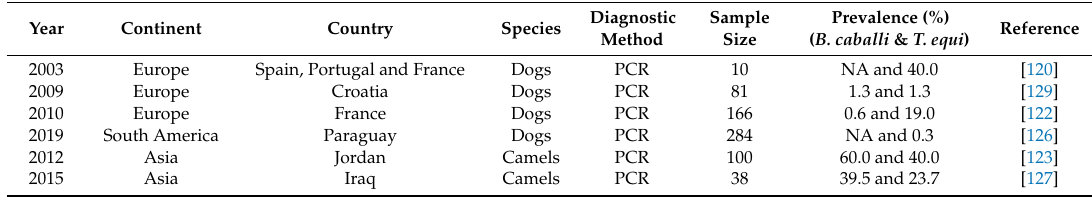
Table 3. Reported prevalence on detection of DNA to Babesia caballi and Theileria equi in dogs and camels in endemic continents and countries using PCR.